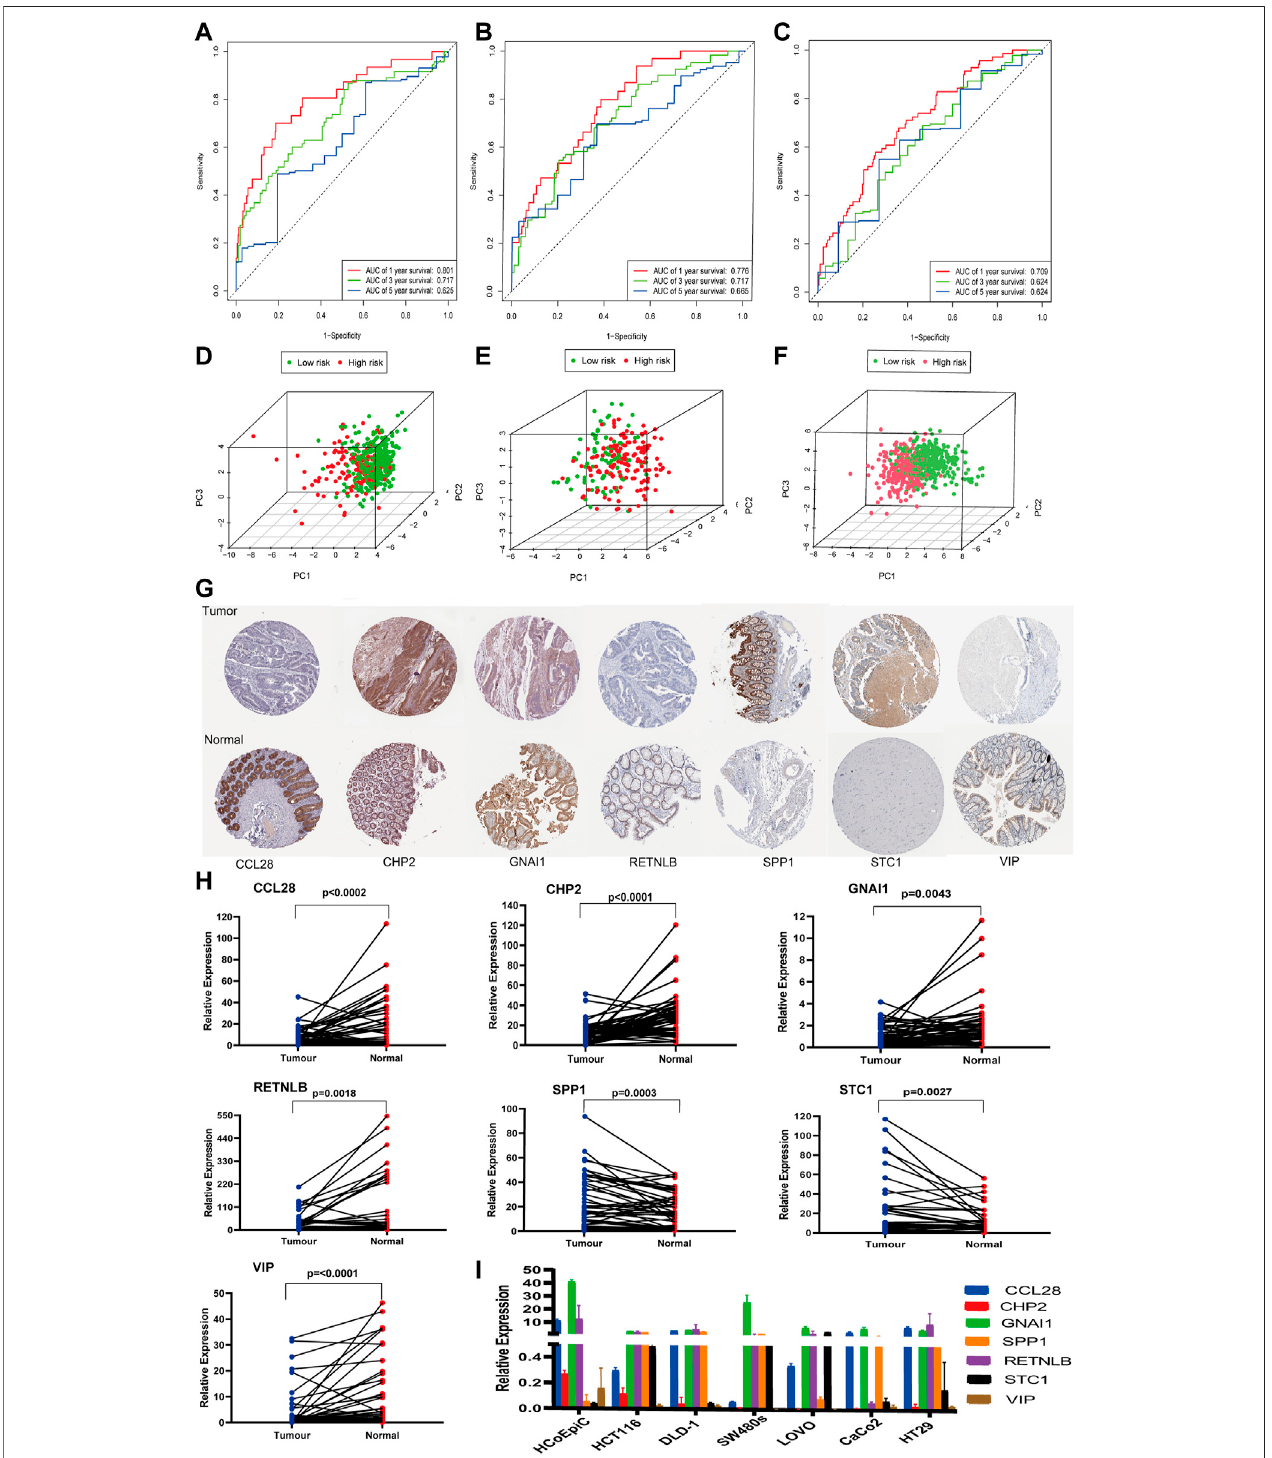
FIGURE 6 | ROC analysis, PCA, HPA analysis, and qPCR. (A – C) ROC analysis using the risk score to predict the OS of the training, test, and validation cohorts. (D – F) PCAofthreecohortimmune-sharegenesisshown. (G) VerifyingdifferentialexpressionofIRGsinnormalcolorectaltissueandCRCusingtheHPAdatabase. (H – I) Veri fi cation of the mRNA expression level of IRGs in fresh tissues and cell lines.